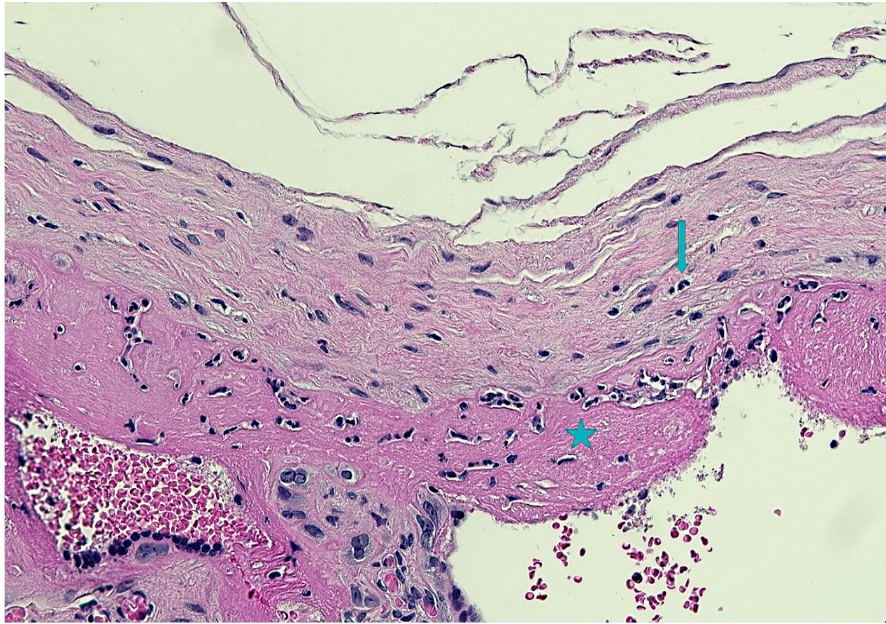
Figure 5. Subchorionitis with focal chorioamnionitis: granulocytes were mainly located in the subchorion (star) with focal extension into the chorion (arrow)(Hematoxylin and Eosin staining, 10 HPF). Funisitis was absent. Parenchyma presented a diffuse delayed villous maturation (Figure 6), focal infarcts, and intraparenchymal hemorrhages at different stages of organi- zation. The decidua presented chronic deciduitis with plasma cells (Figure 7). Immunohis- tochemistry for T. pallidum resulted as negative.